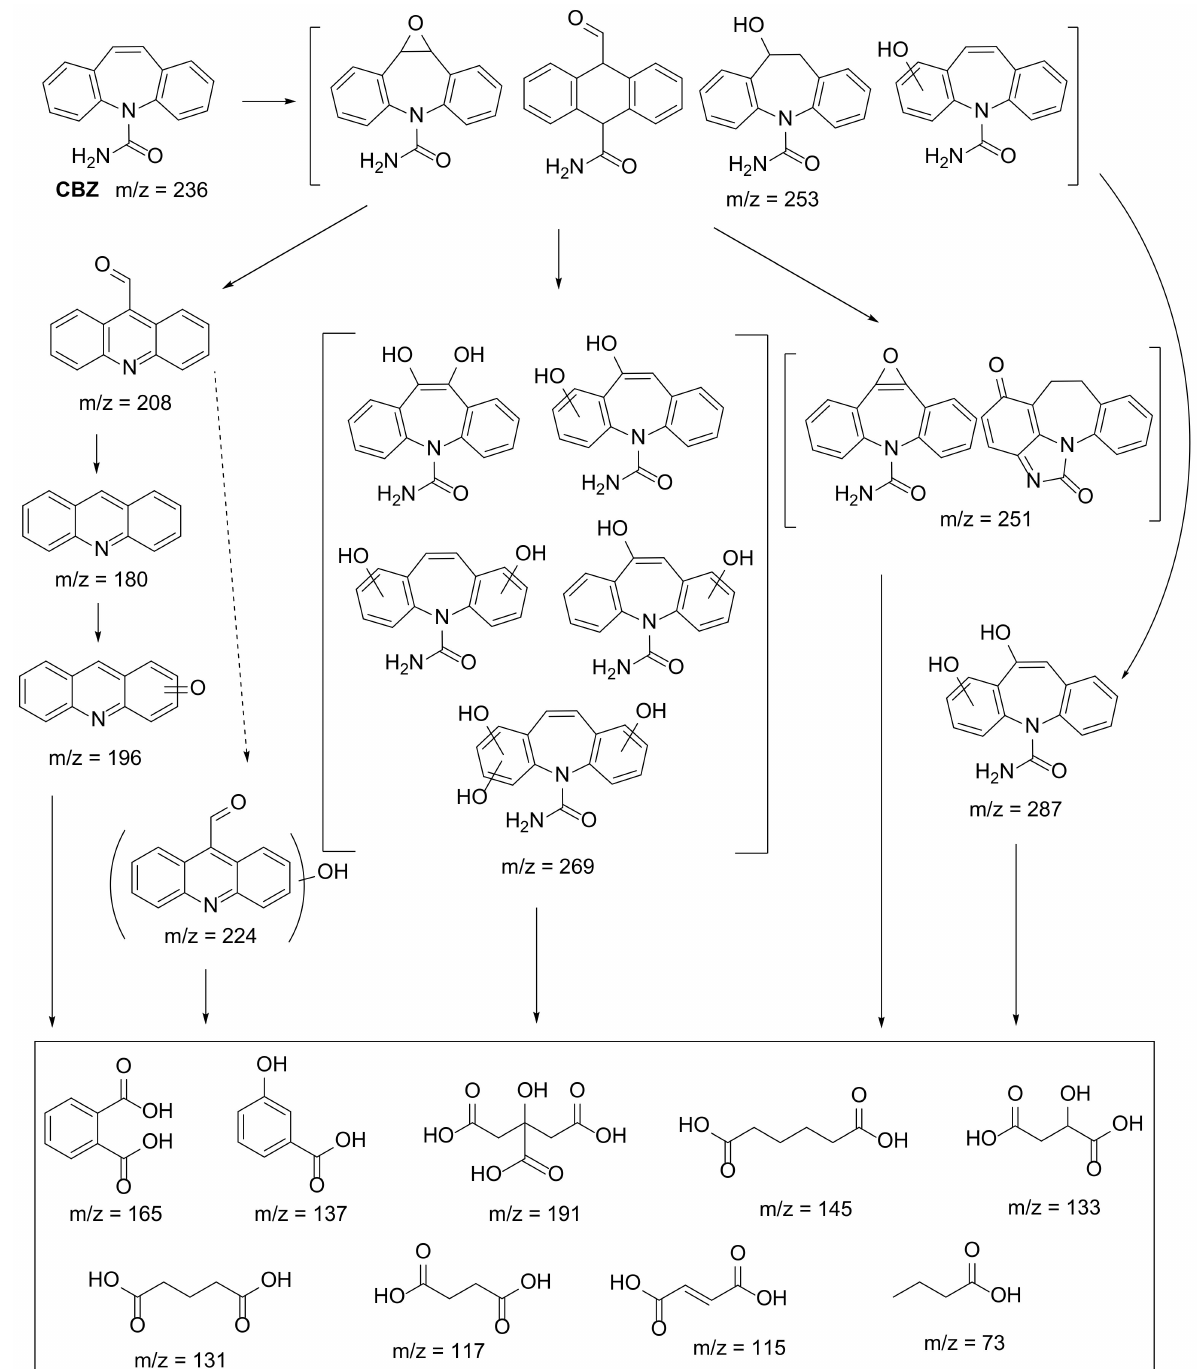
Scheme 8. Proposed degradation pathway for